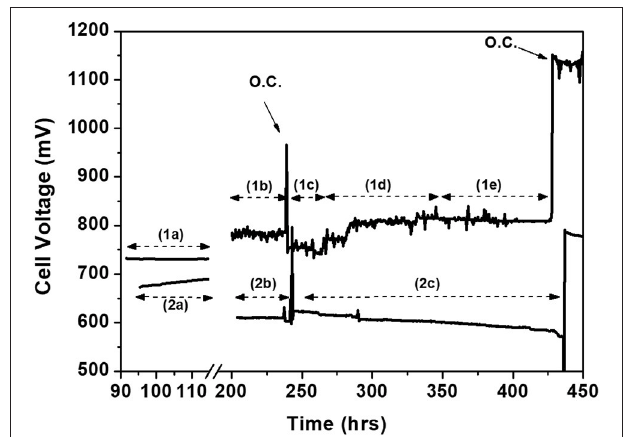
FIGURE 14 | Stability test diagram of two cells comprising 1.5 at% Au-Ni/GDC and Ni/GDC as anodes at T = 850 ◦ C and 500 mAcm − 2 . Label 1 corresponds to the performance of the cell with the Au-modified anode and label 2 to the blank cell. Conditions: ( 1a ) H 2 -3%H 2 O F anode = 520 ccmin − 1 , ( 1b ) S/C ≈ 3/2: = 41.2 kPa, F anode = 224 ccmin − 1 , ( 1c ) reformate = 60.2 kPa, P CH P H 2 O 4 feed: 77 vol.% H 2 , 8 vol.% CO, and 15 vol.% H 2 O, F anode = 374 ccmin − 1 , = 68.3 kPa, F anode = 135 ccmin − 1 , = 33.0 kPa, P CH ( 1d ) S/C ≈ 1/2: P H 2 O 4 ( 1e ) dry CH 4 feed, F anode = 90 ccmin − 1 . ( 2a) H 2 -3%H 2 O F anode = 856 ccmin − 1 , ( 2b ) S/C ≈ 3/2: P